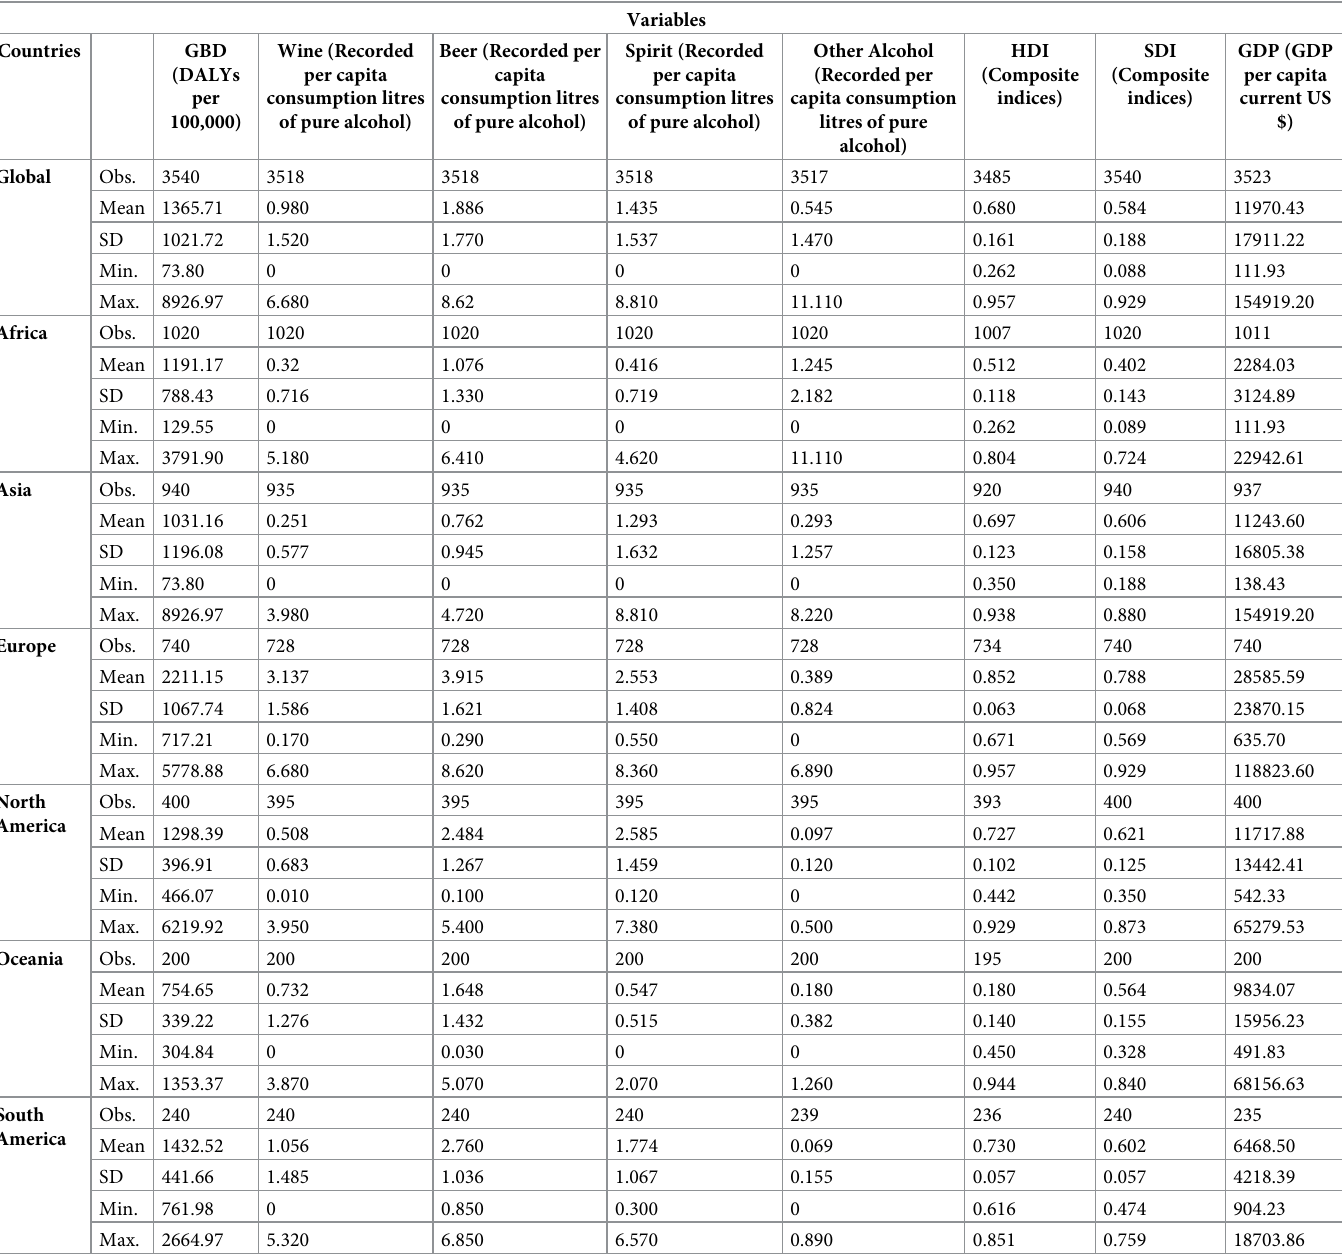
Table 2. Summary descriptive statistics for the key